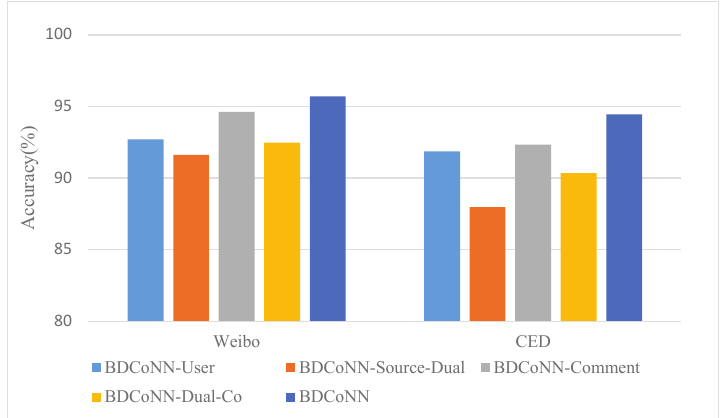
Figure 4. Results of the ablation experiments on the Weibo and CED datasets.